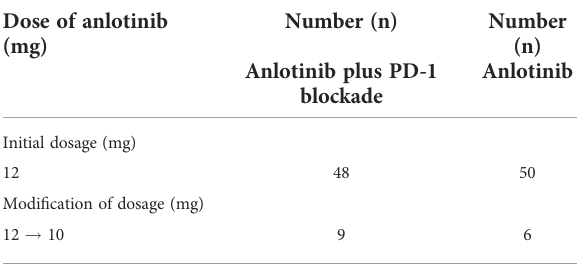
PD-1 blockade, Programmed death-1